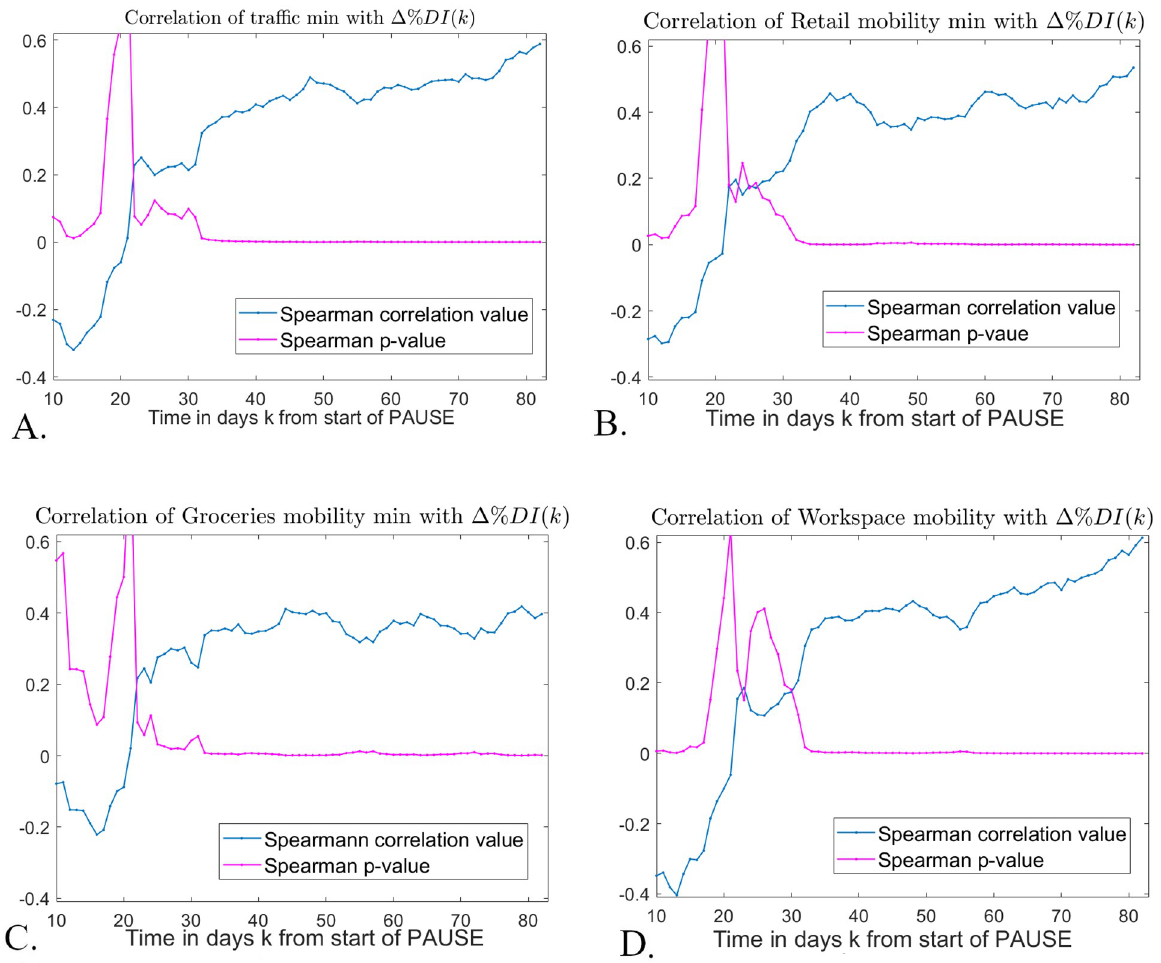
Fig 8. Spearman correlations between traffic/mobility lowest levels after PAUSE, and epidemic recovery before June 20, 2020. We start our assessment of traffic/mobility comeback at the 10th day after the start of PAUSE, so as to allow for the smoothed traffic/mobility time series to achieved their lowest levels (recall that these occurred within a nine day window from the start of PAUSE, when considering smoothed traffic time series). For each day k � 10 after the start of PAUSE (represented along the horizontal axis) we computed correlations between the traffic/mobility lowest level and the epidemic recovery measure Δ % DI . The values of Δ % DI were computed from the smoothed epidemic time series, for 10 � k � 83 days. In each panel, the day 10 � k � 83 is represented on the horizontal axis; the corresponding correlation and significance values are shown as blue and respectively purple curves. Each panel illustrates the results for a different traffic /mobility data set: A. driving, as percent of baseline; B. mobility to Retail; C. mobility to Grocery; D. mobility to Workspace, as percents of the reference day